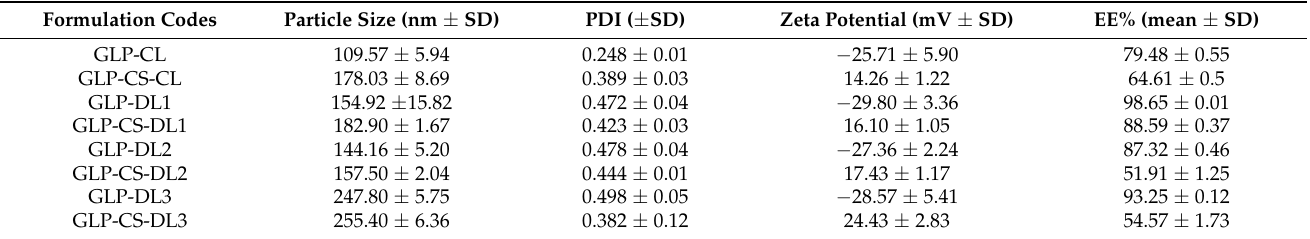
Table 2. Characterization of the formulated CL-, DL-, and CS-coated liposomes containing GLP. Formulation